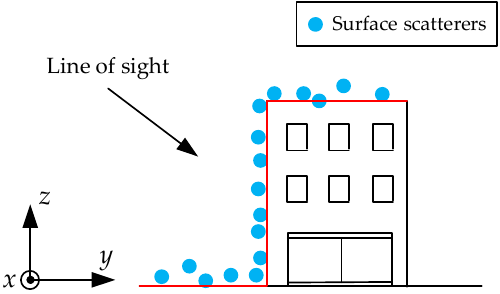
Figure 3. Schematic geometry of the 3-D building model. Red lines denote the “visible” plane.